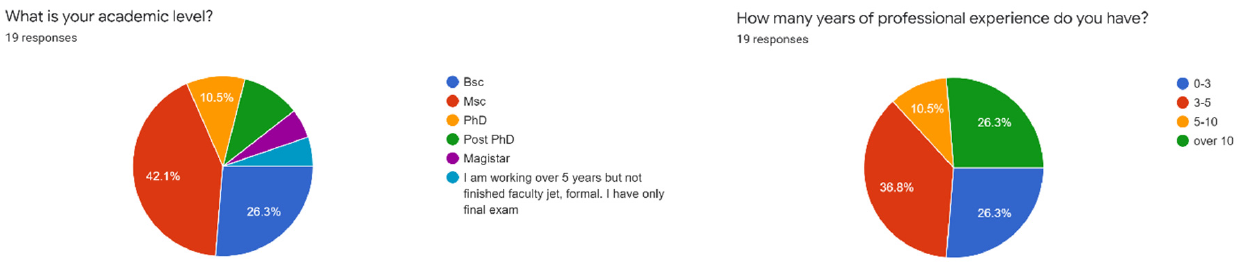
Figure 7. Demographic analysis of the participants in the pilot user